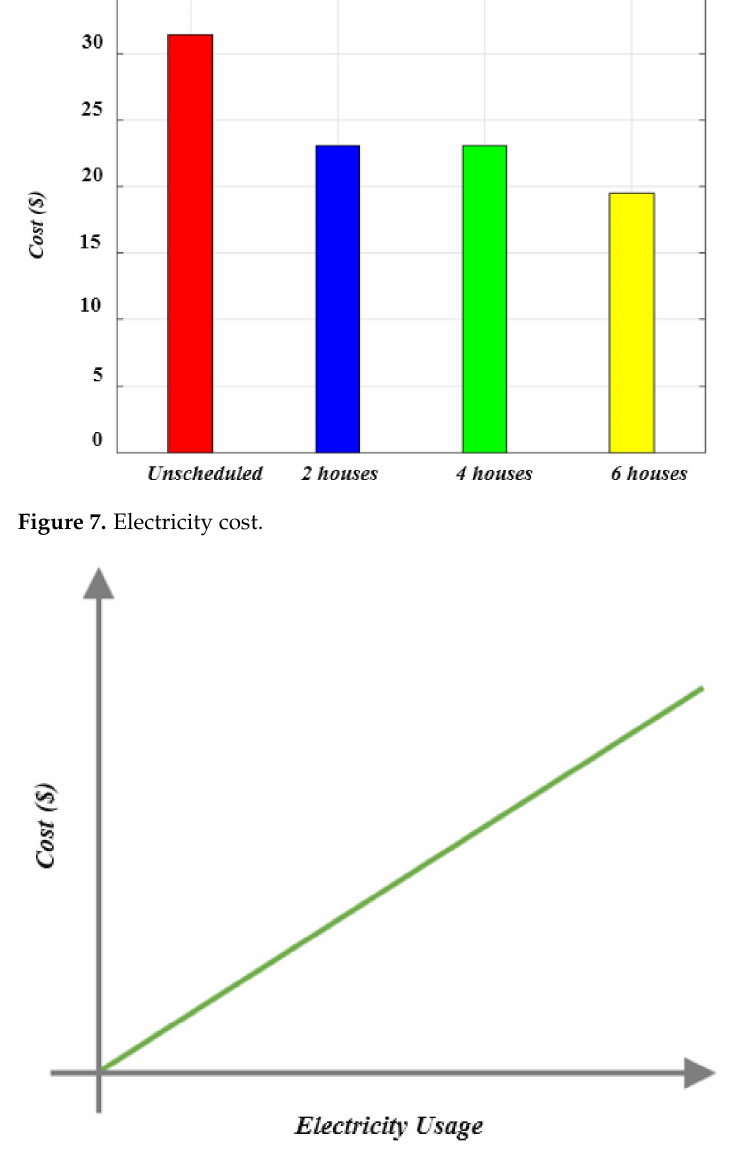
Figure 8. Electricity cost vs power